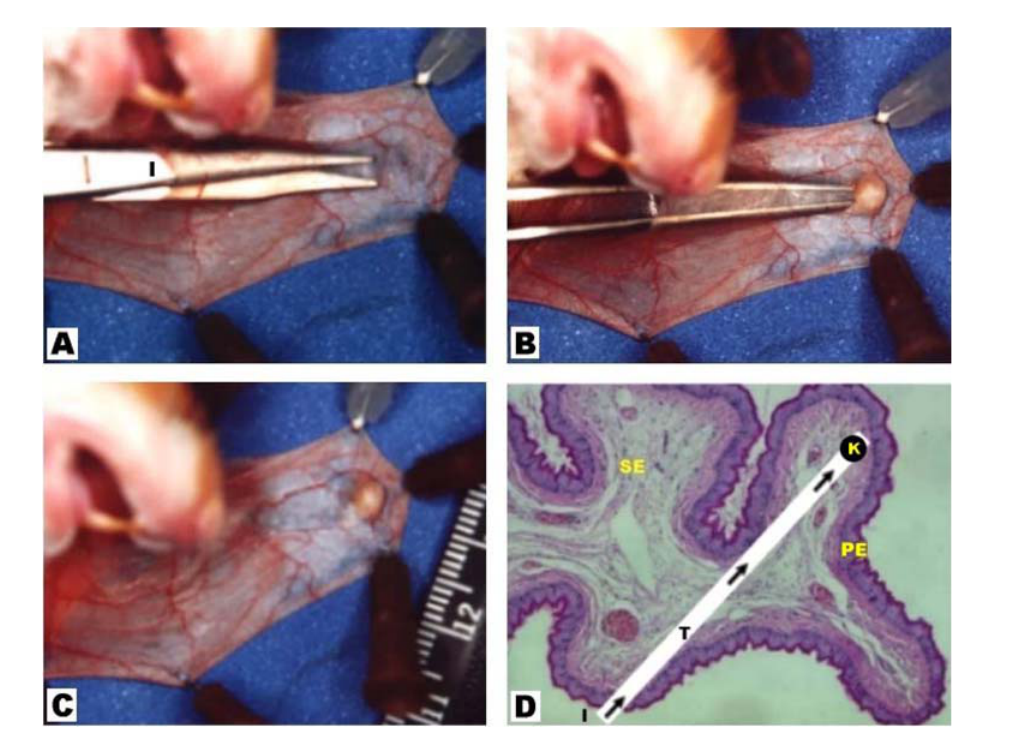
FIGURE 4 - Surgical technique of grafting into hamster cheek pouch. A) Rhomboid subepithelial divulsion in tunnel, towards a pouch distal position. B) Insertion of keloid fragment with long and thin pincers. C) Aspect of the fragment grafted after accommodation by digital compression of adjacent epithelium. D) Microscopic cut of hamster cheek pouch, dyed by hematoxylin-eosine (HE) when seen with 100X magnification, to show schematically the incision (I) of pouch epithelium (PE), the tunnel disection (T) of the sub-epithelium (SE) and the grafted keloid fragment positioning